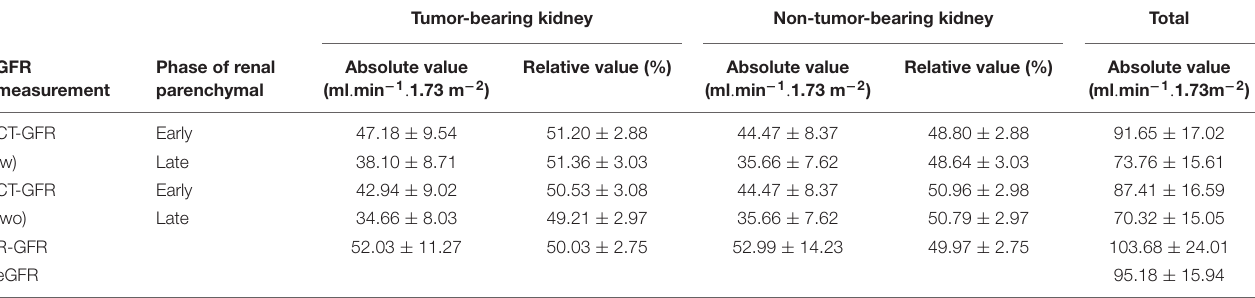
TABLE 1 | Results of statistical of GFR by three methods ( ¯ x + s ).